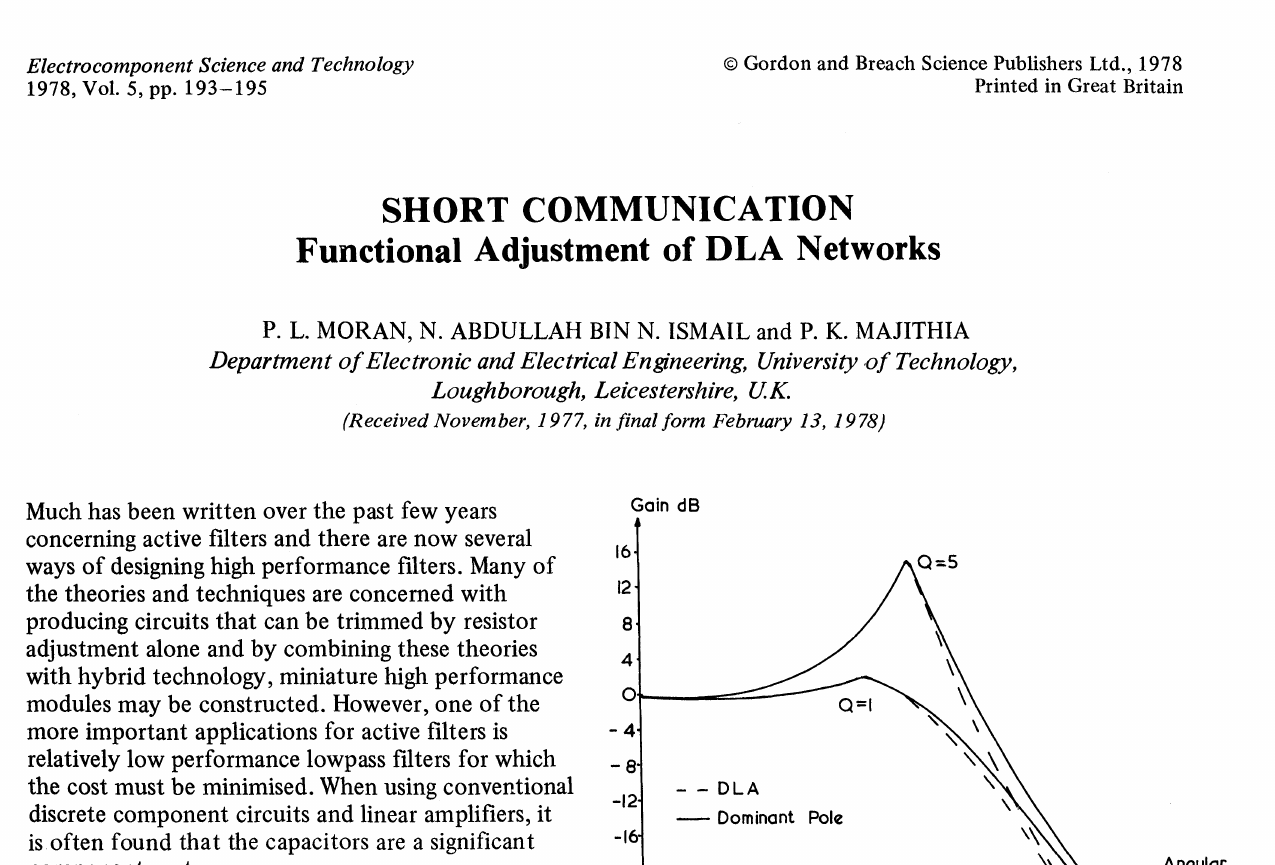
Comparison between amplitude of D.L.A. transmission function and the equivalent dominant pole transmission function.